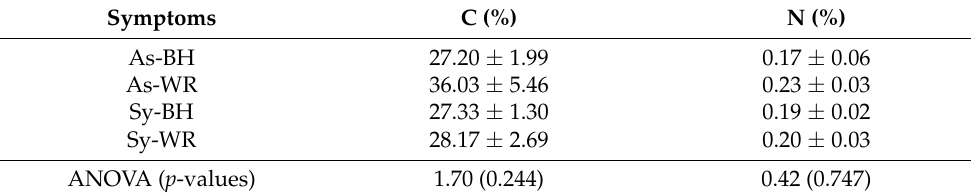
Table 2. Percentage of carbon (C) and nitrogen (N) resulting from the grapevine wood samples.